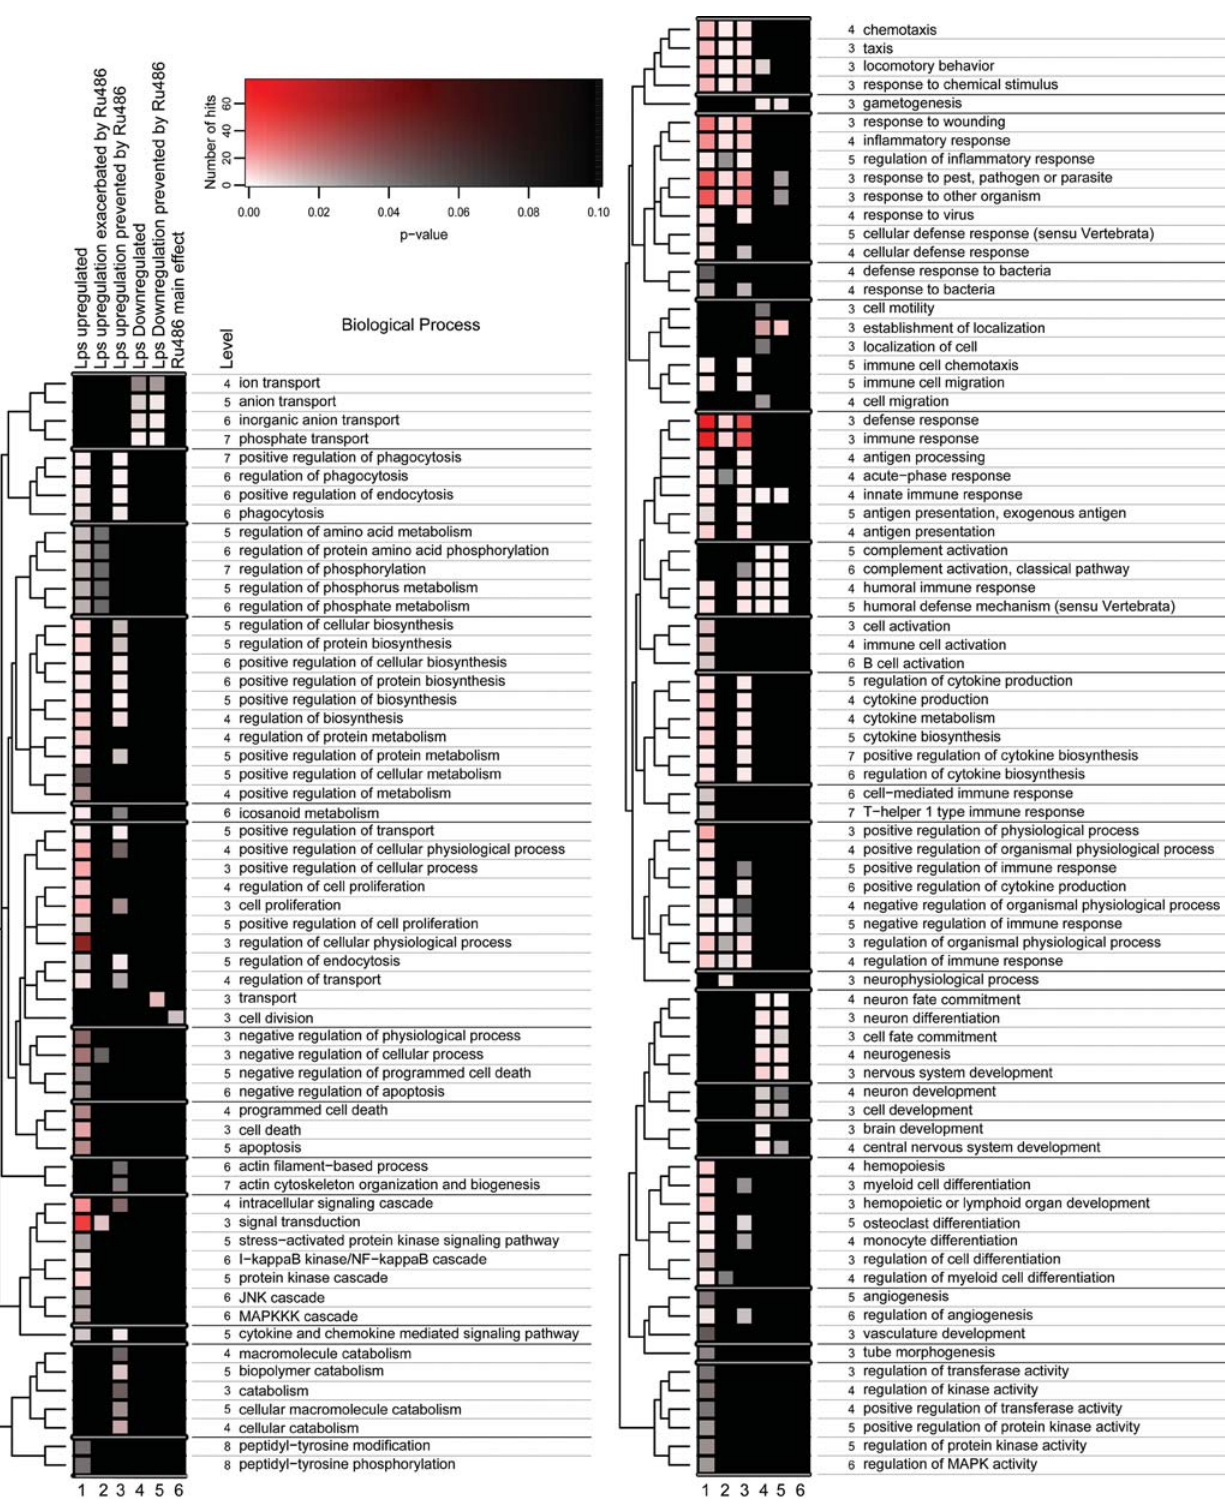
PLoS ONE | www.plosone.org